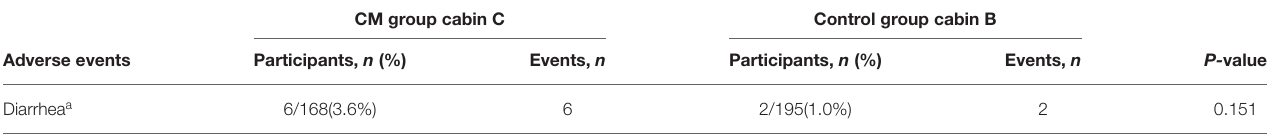
TABLE 5 | CM granule-related adverse